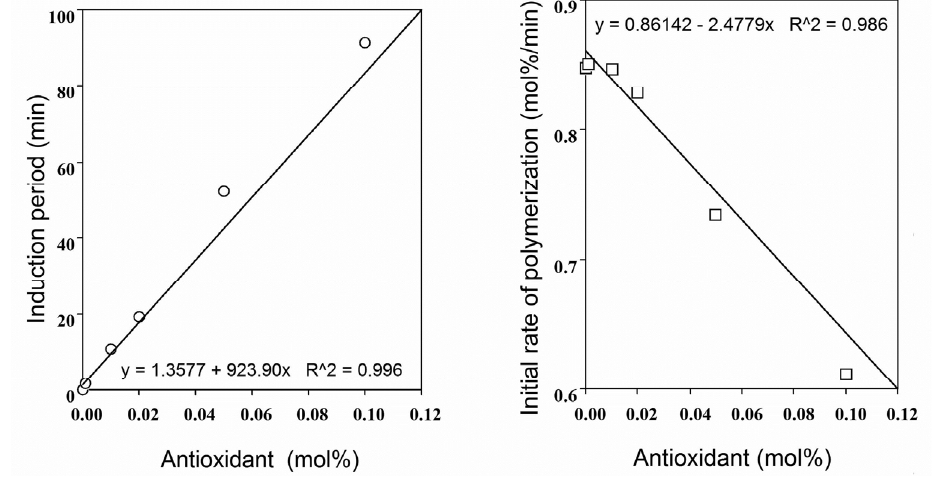
Figure 4. Plots of the induction period (left side panel) or the initial rate of polymerization (right side panel) against the concentrations of